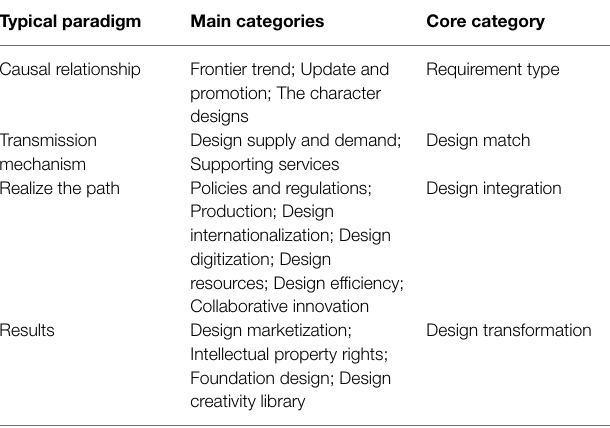
TABLE 3 | Selective coding.